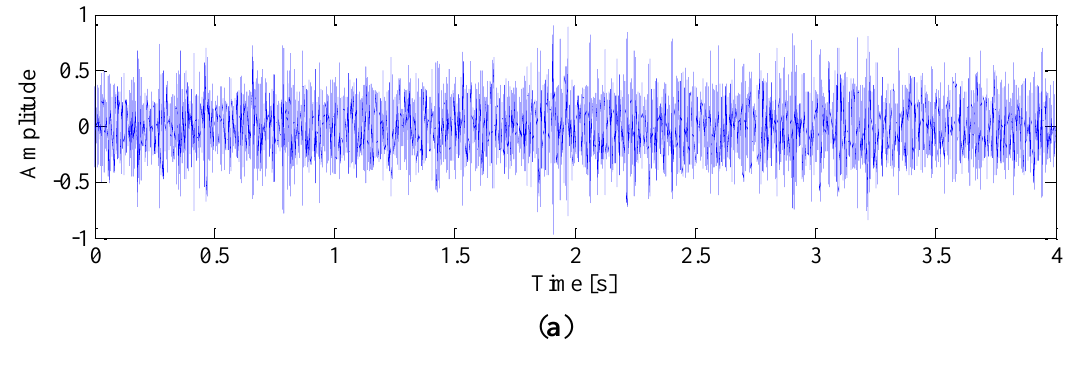
Figure 6. ( a ) Band-pass filtered signal; ( b ) The envelope signal of